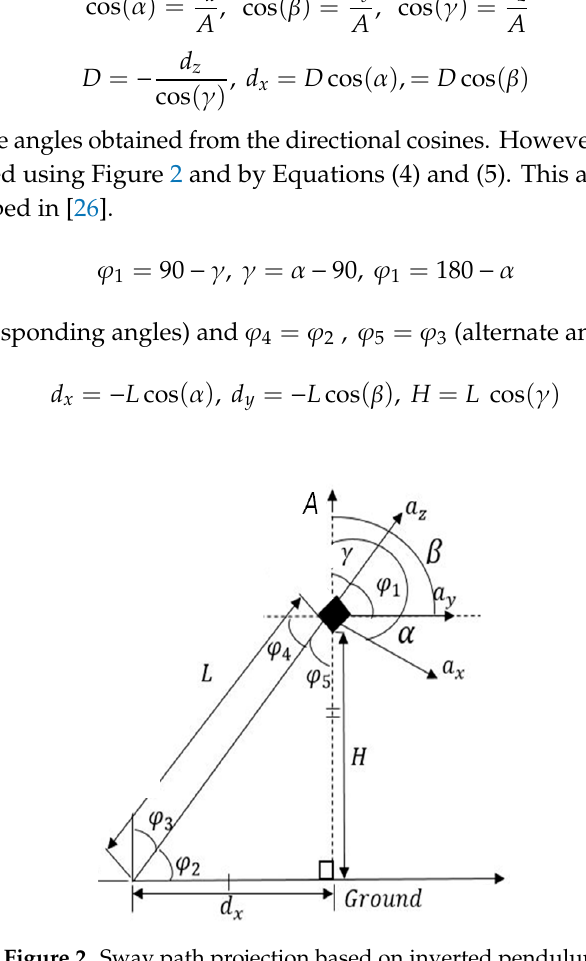
Figure 2. Sway path projection based on inverted pendulum.